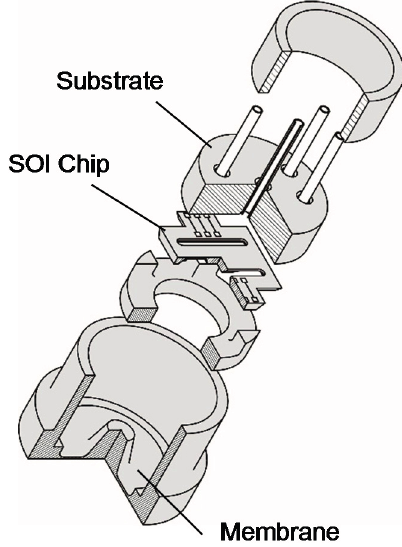
Figure 3. Exploded view of the “Flip-Chip”-Sensor concept for use in harsh environments.